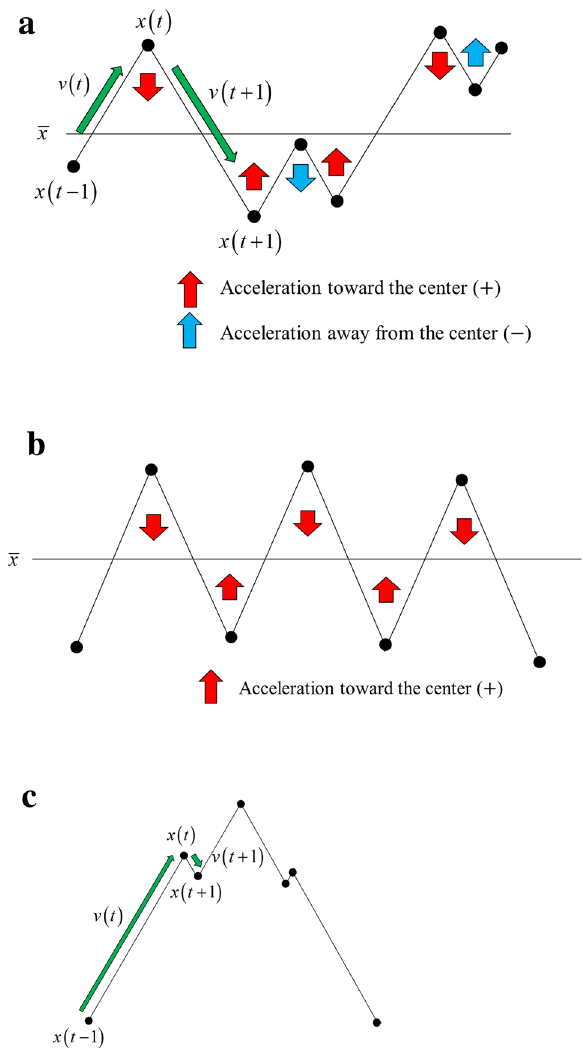
Figure 1. ( a ) Direction of acceleration. Note : Acceleration toward the center is positive, and acceleration away from the center is negative. ( b ) Acceleration for rough waveform. Note : The more the waveform crosses the centerline, the greater the proportion of acceleration towards the center. ( c ) Waveform when there is a bias between two adjacent velocity vectors. Note : When the absolute values | v ( t ) | and | v ( t + 1 ) | of two adjacent velocity vectors differ greatly, the entire waveform tends to be